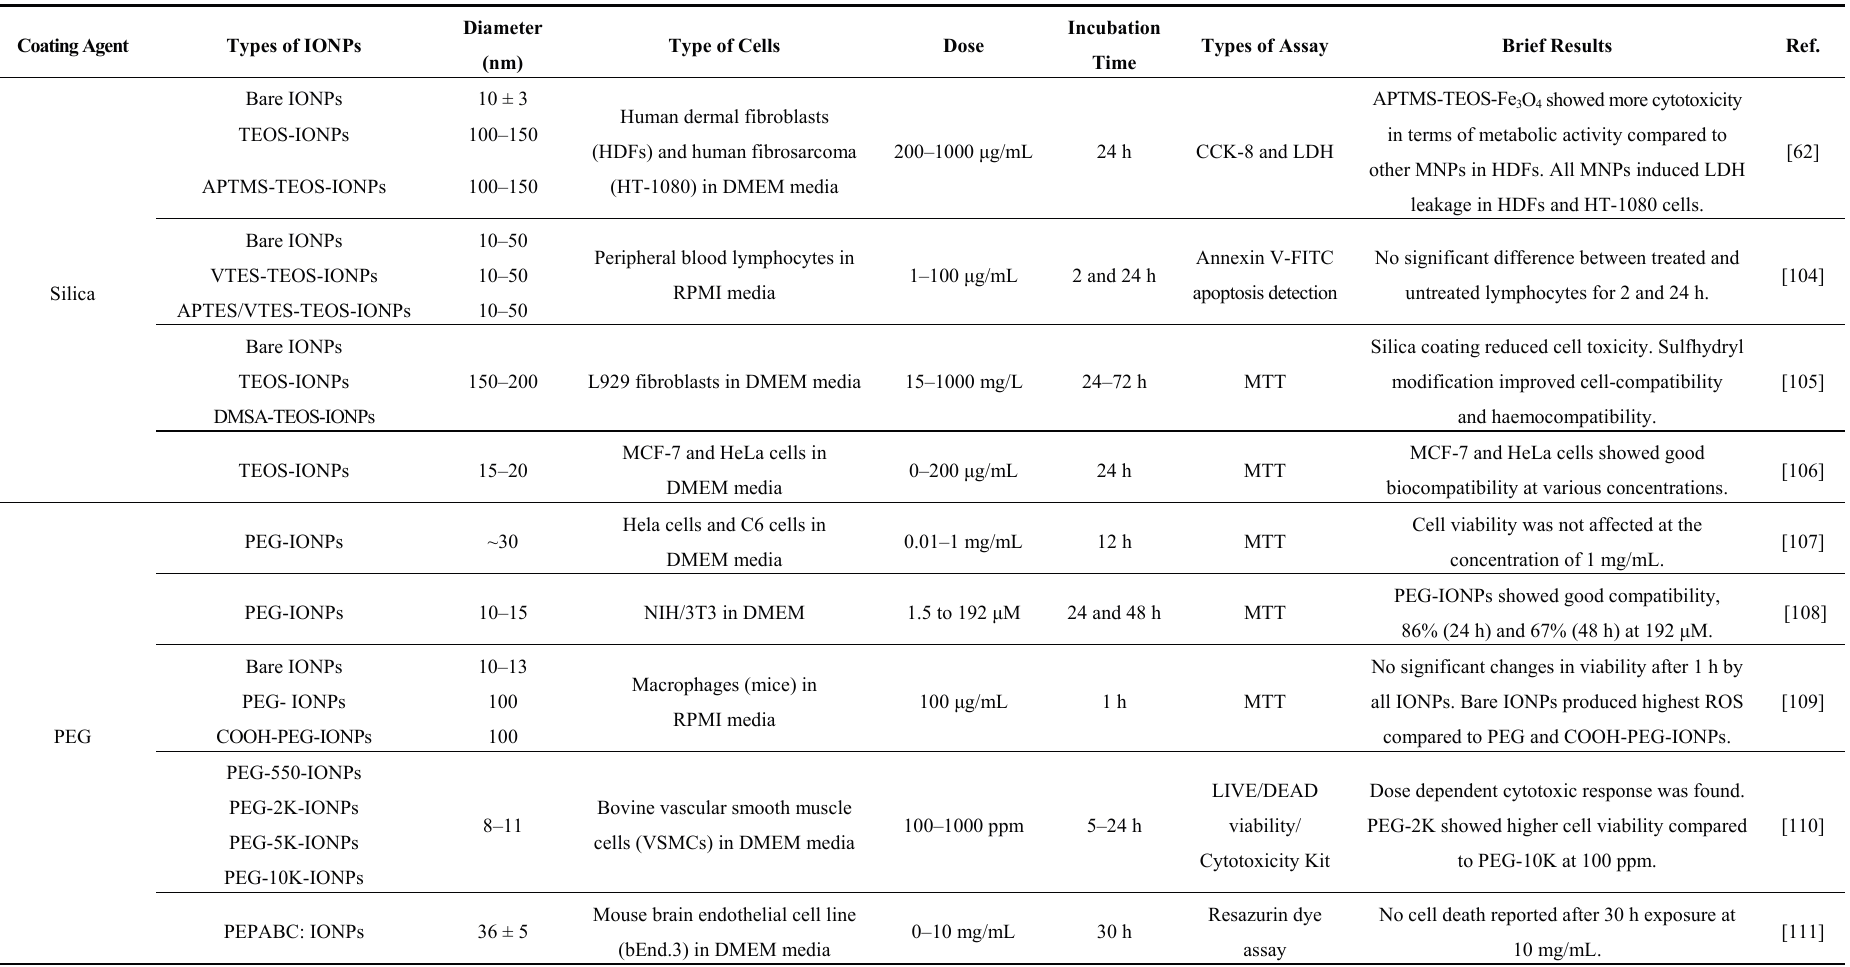
Table 1. Brief overview of recent in vitro cytotoxic studies of iron oxide nanoparticles (IONPs), organized with emphasis on physicochemical parameters of IONPs. Majority of IONPs discussed in these studies were spherical in